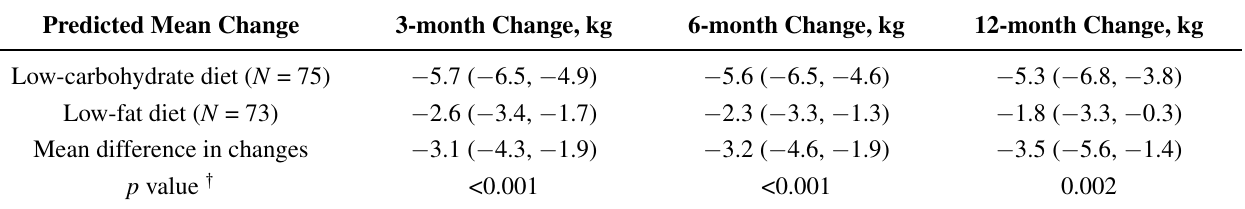
Table A1. Predicted mean change in body weight by assigned dietary group * .